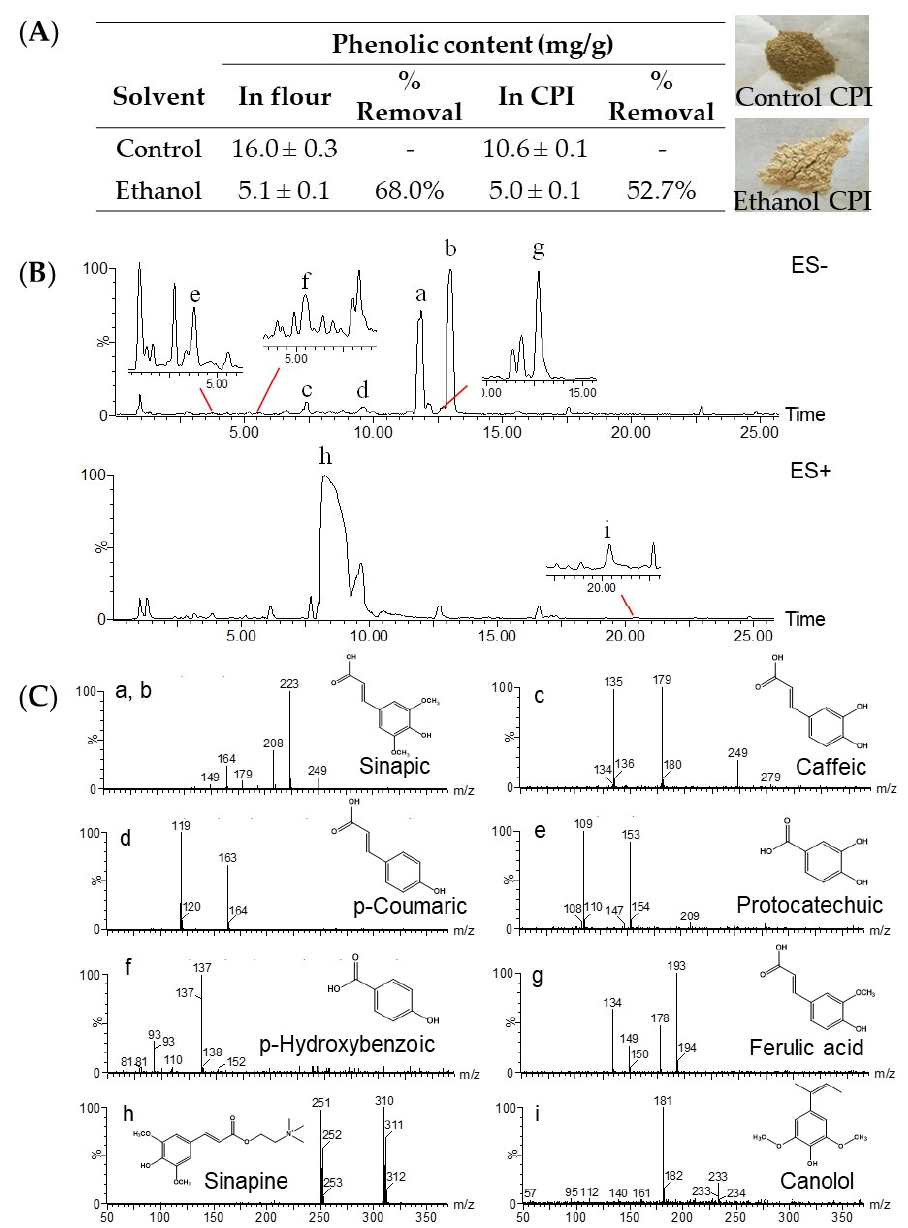
Figure 1. Total phenolic content (mg/g) in canola seed flour and protein isolate (CPI) dephenoled with 70% ethanol ( A ); representative UPLC − TOF − MS chromatogram ( B ); structure ( C ); of phenolic compounds (a–i) extracted from canola flour.